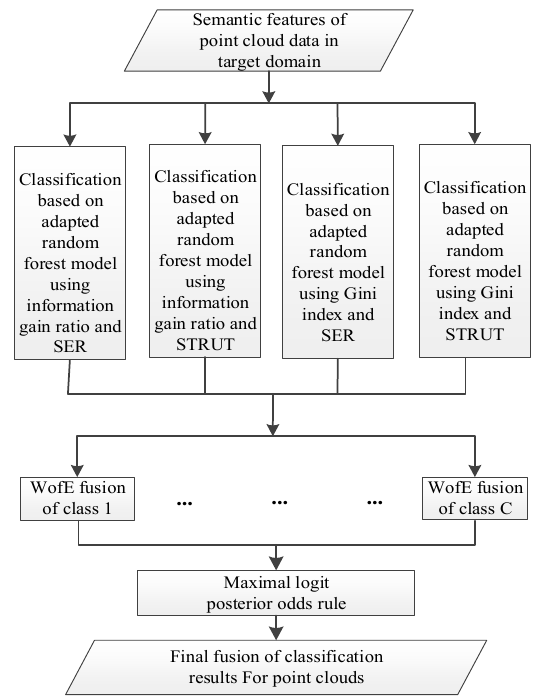
Figure 1. Workflow for point cloud data classification based on WofE